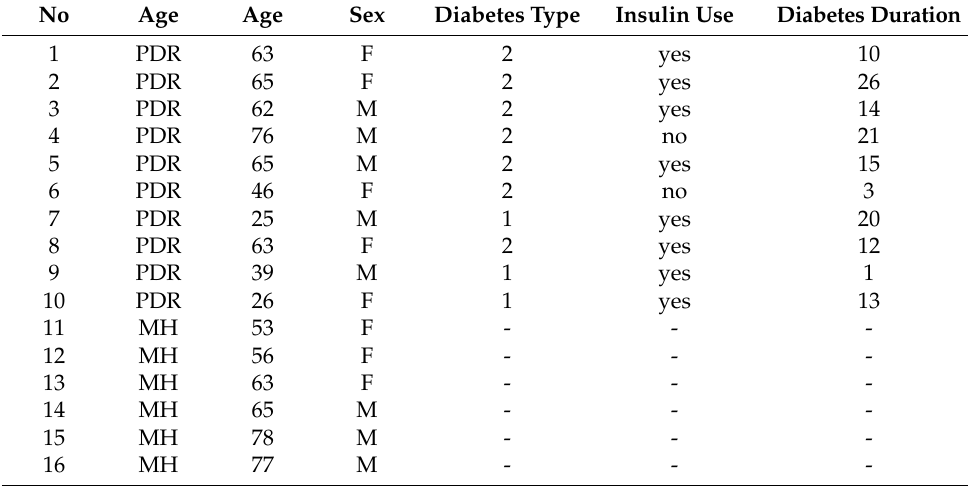
Table 1. Patient